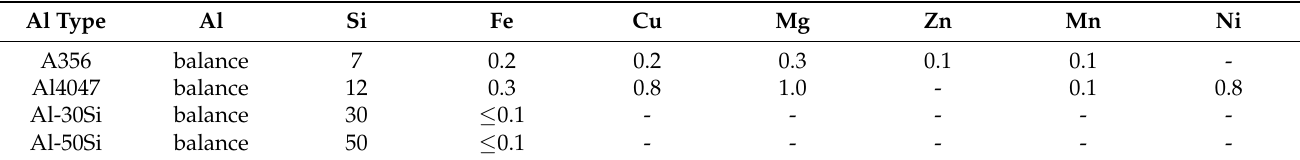
Table 1. Chemical compositions of the Al alloys used in this study